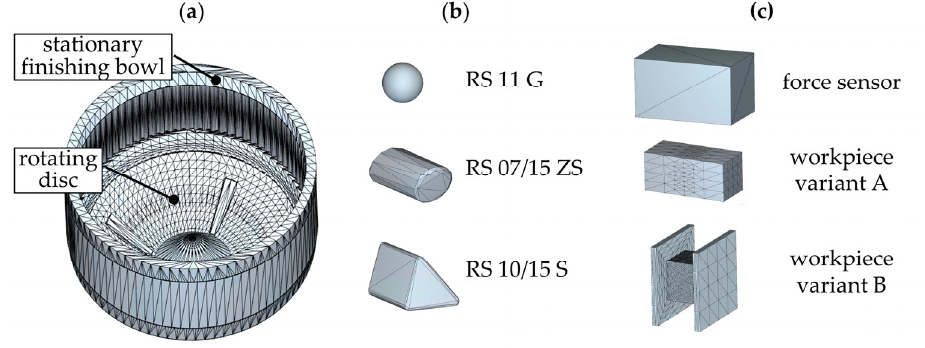
Figure 5. STL models of the simulation components (not true to scale): ( a ) finishing machine; ( b ) media; ( c ) workpieces. Table 1. Material parameters of the simulation